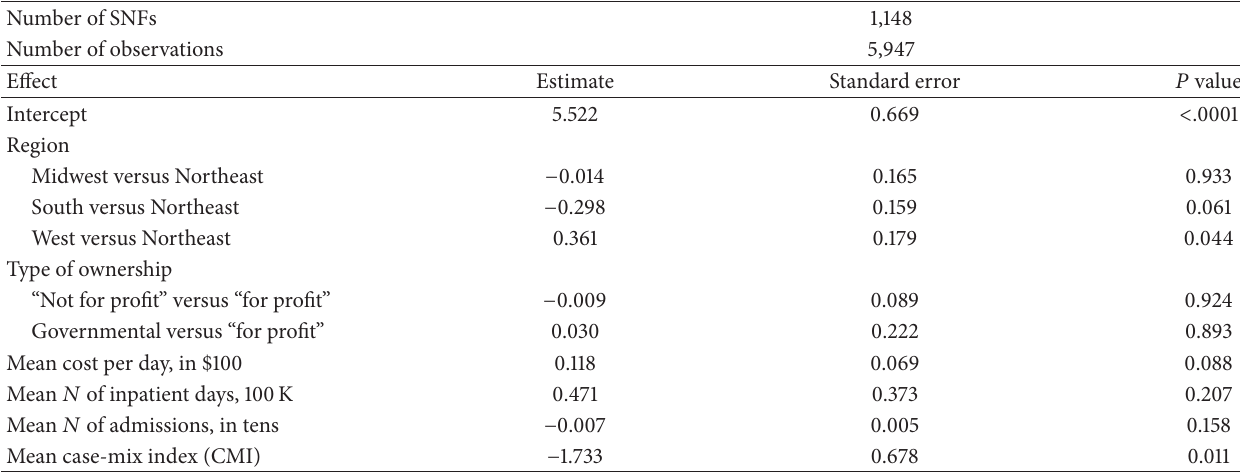
Table 3: Factors contributing to variation in MS days among facilities with high MS